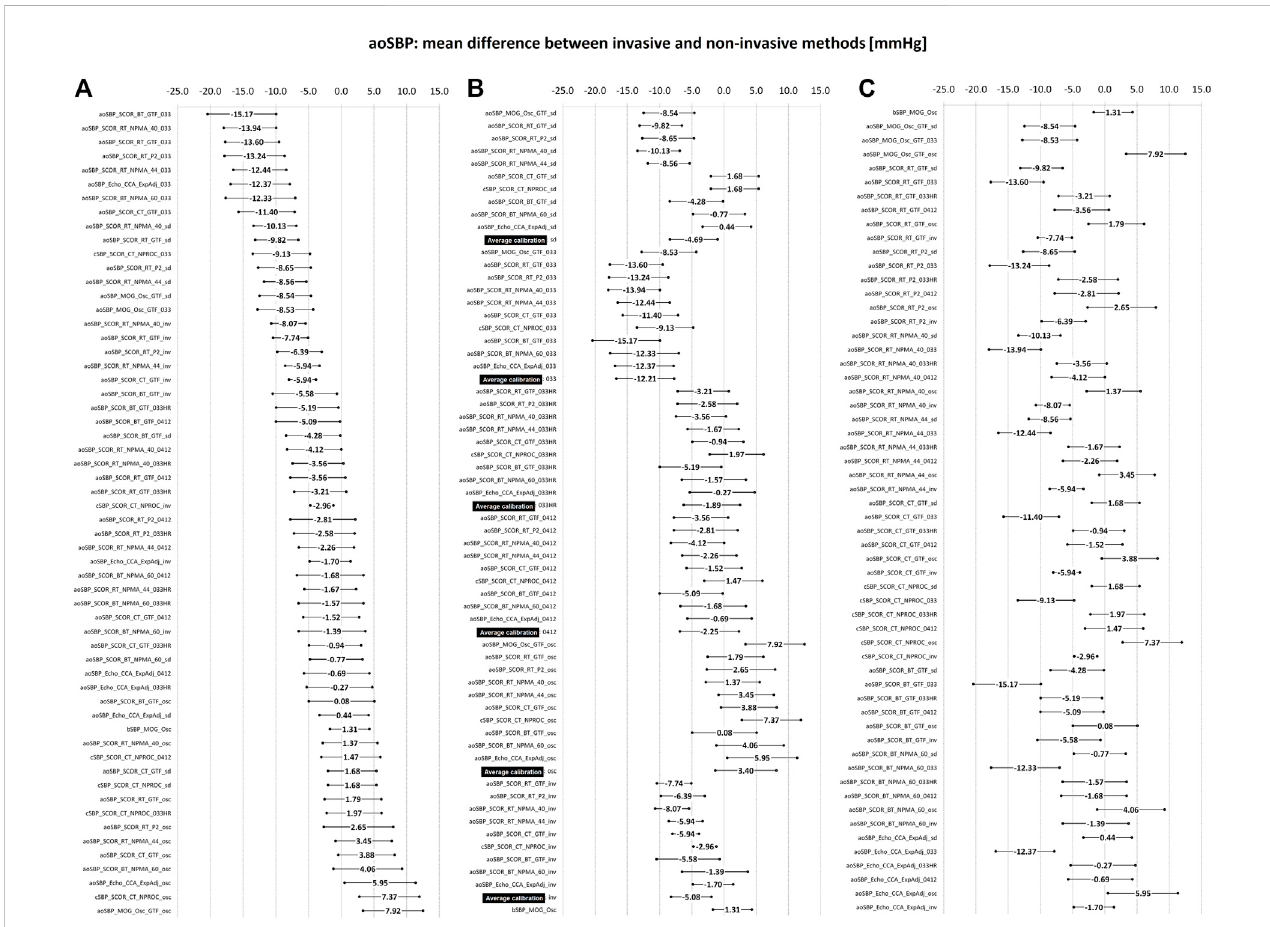
FIGURE 3 Bland-Altmanderivedmeanerror(and95%con fi denceintervals)forcomparisonsbetweennon-invasiveandinvasiveaoSBPmeasurements. (A)